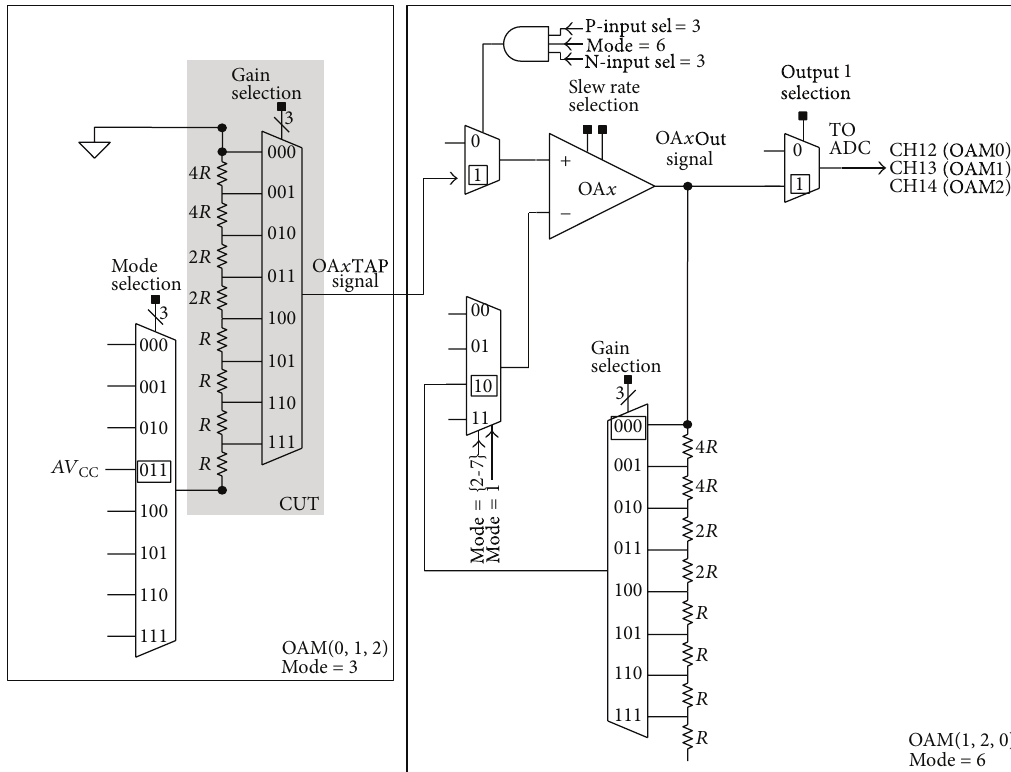
Figure 6: Setup of OA modules for testing the resistor arrays.